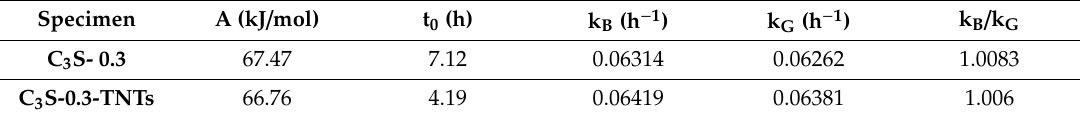
Figure 8. Standard boundary nucleation and growth fitting (solid line) to the C 3 S hydration kinetic data ( (cid:35) Table 4. Fitting parameters obtained by applying the boundary nucleation and growth models to C 3 S-0.3 and C 3 S-0.3-TNTs hydration